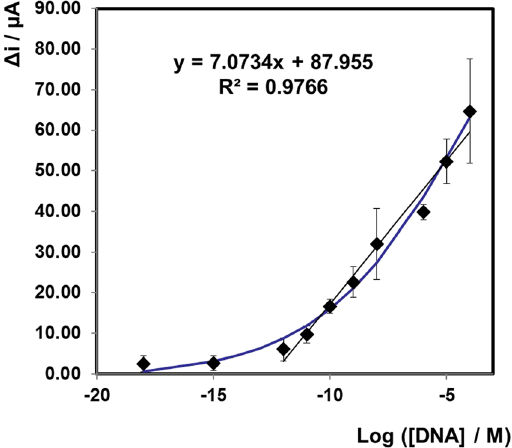
Figure 3. Dependence of the difference in current before and after the addition of H 2 O 2 on log[miRNA] on a gold slide electrode following hybridisation with probe miRNA that is labelled with PtNPs. The applied potential is − 0.25 V in 1 mM DPBS. Δ i represents the difference in current before and after addition of 20 µ M H 2 O 2 . Error bars are from an n = 3 study and range from 4–13%. The calibration plot is fit with a 4 parameter logistic function (blue